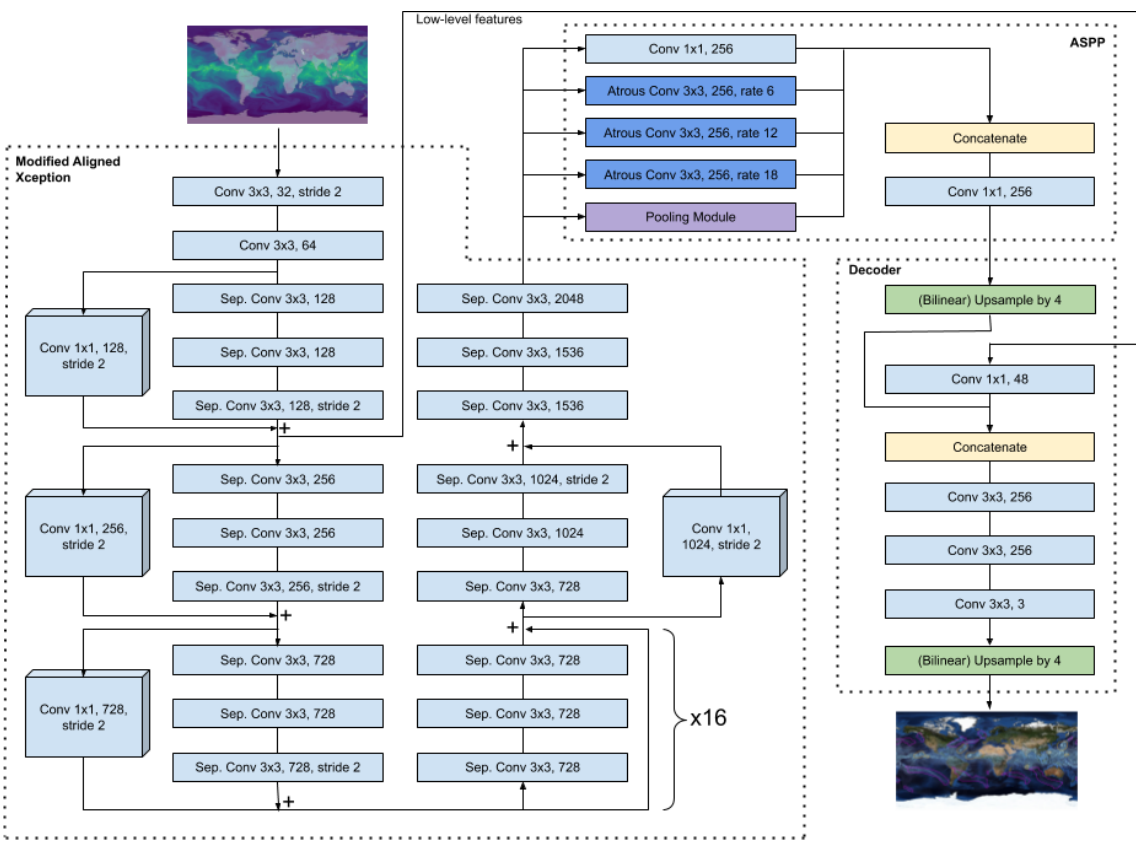
Figure 3. DeepLabv3+ network: all convolutional layers are followed by a batch normalization and a rectified linear unit (ReLU) activation layer, which are omitted from this schematic for the sake of brevity. “Sep. Conv” denotes depth-wise separable convolution. The pooling module consists of a two-dimensional pooling layer, followed by a convolutional layer, a batch normalization layer, and a ReLU activation layer. For more details, we refer the reader to Chen et al.